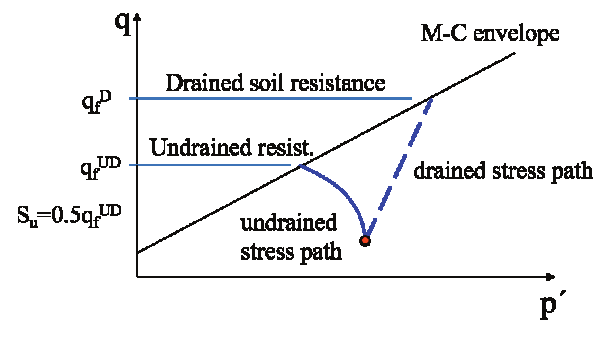
Fig. 11. Schematic representation of shear strength for normally consolidated material in drained and undrained